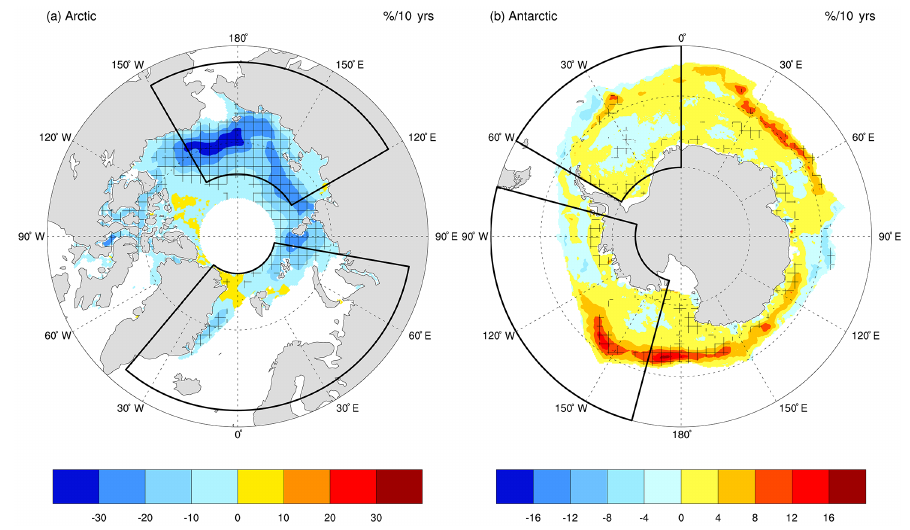
Figure 1. Linear trends of September sea ice concentration for (a) Arctic and (b) Antarctic during the period of 1979–2014. The meshed areas denote the trends above 95% confidence level. Boxes indicate the areas used to generate the regional sea ice